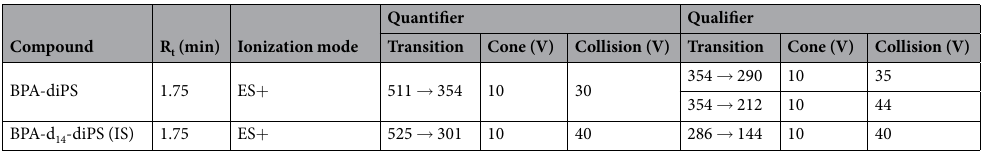
Table 4. MS/MS parameters for the analysis of derivatized BPA and derivatized IS. Abbreviations: R t : retention time; ES+: positive electrospray